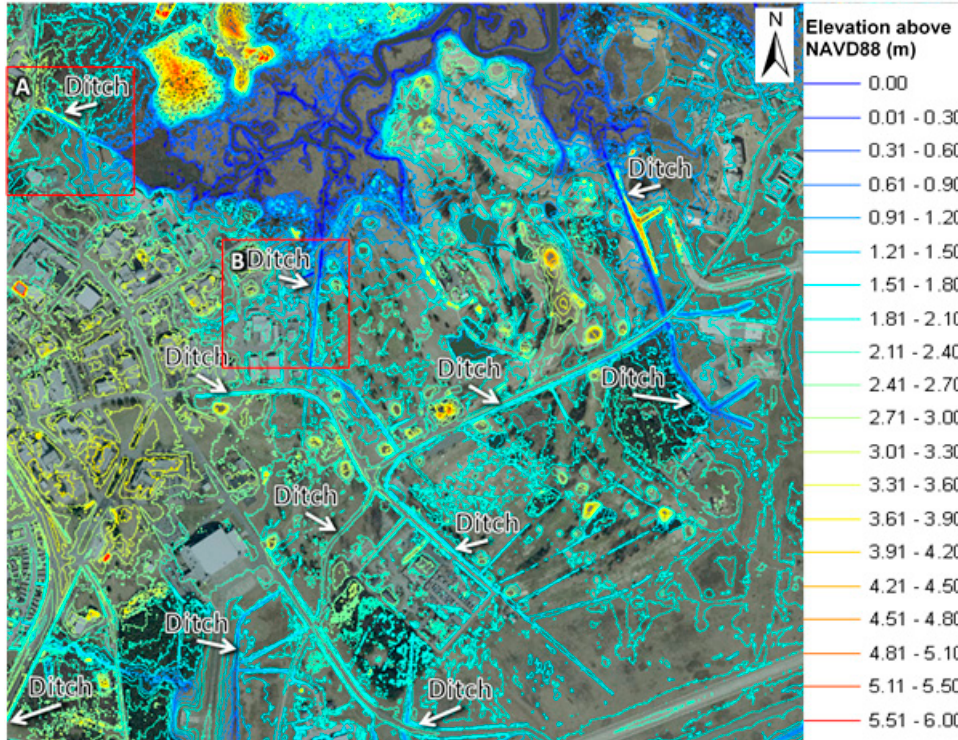
Figure 11. Examples of obtaining aerial elevations from lidar and conducting hydro-correction to assure unobstructed ditch and creek channels persist for hydrologic transport of king tide inundation in the City of Hampton, VA. Red highlighted boxes correspond to areas depicted in Figure 12A,B.